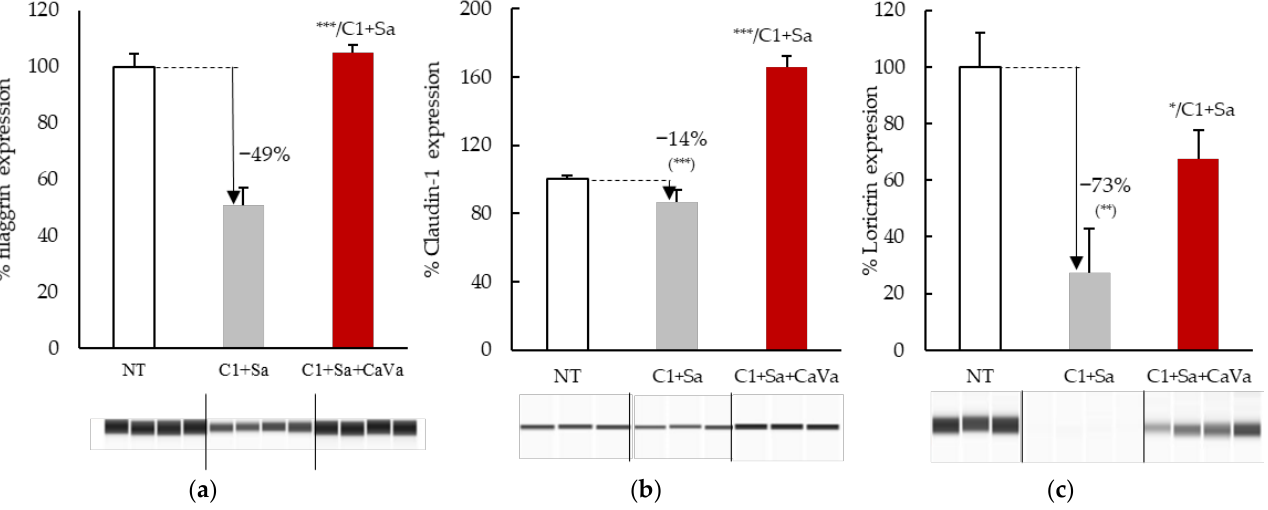
Figure 2. Modulation of the expressions of filaggrin ( a ), claudin-1 ( b ) and loricrin ( c ) in reconstructed human epidermis (RHE) treated with the inflammatory cocktail of cytokines and S. aureus (C1 + Sa), without and with an additional treatment with a Castanea sativa extract (CaVa). RHE total proteins were analyzed by immunoblotting (representative blots are shown), and the images were scanned to quantify the immunoreactive protein amounts. Mean values ± SD are shown, n = 3; Student t -test; *, p < 0.05; **, p < 0.01; ***, p <